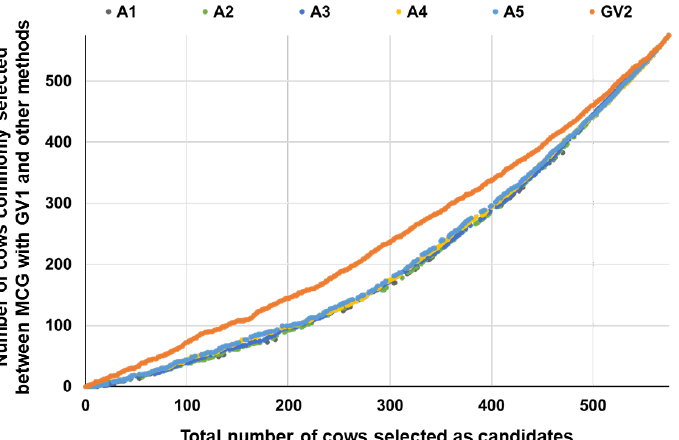
Figure 3. Changes in number of cows commonly selected between MCG with GV1 matrix and other methods.